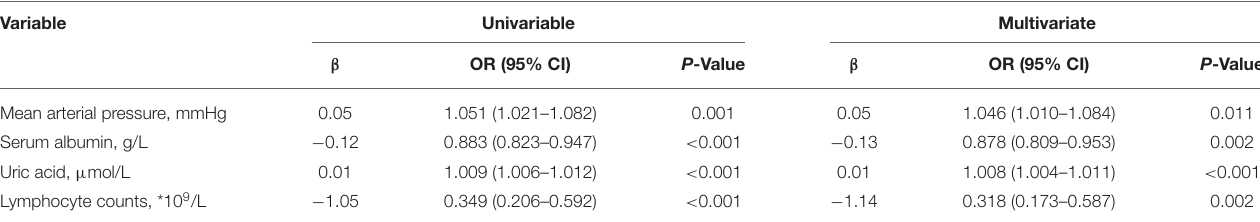
TABLE 2 | Univariable and multivariate logistic regression analysis results. Variable